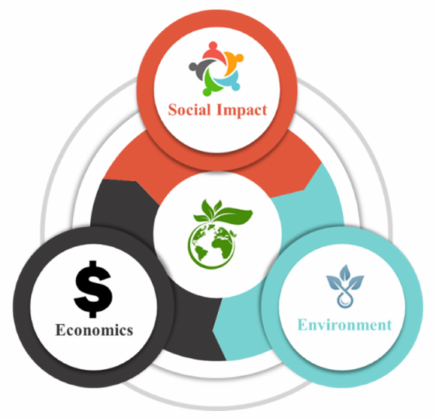
Figure 1. Three Pillars of Sustainability, reprinted with permission from ref. [16]. Copyright 2017 BSP books Pvt